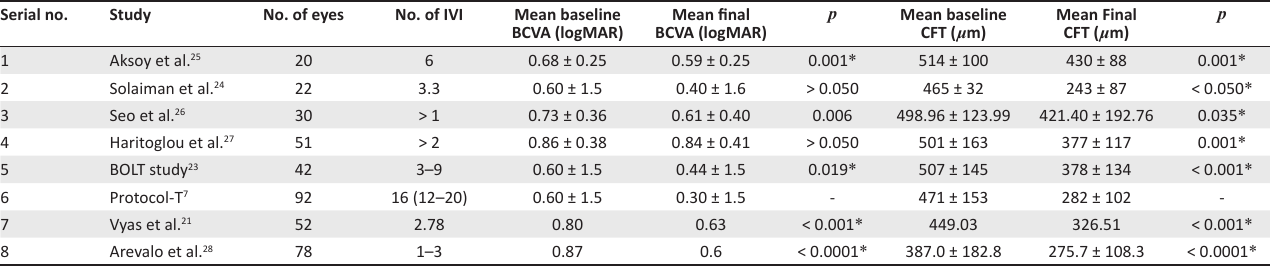
TABLE 3: Comparison between studies similar to the present study. Serial no.